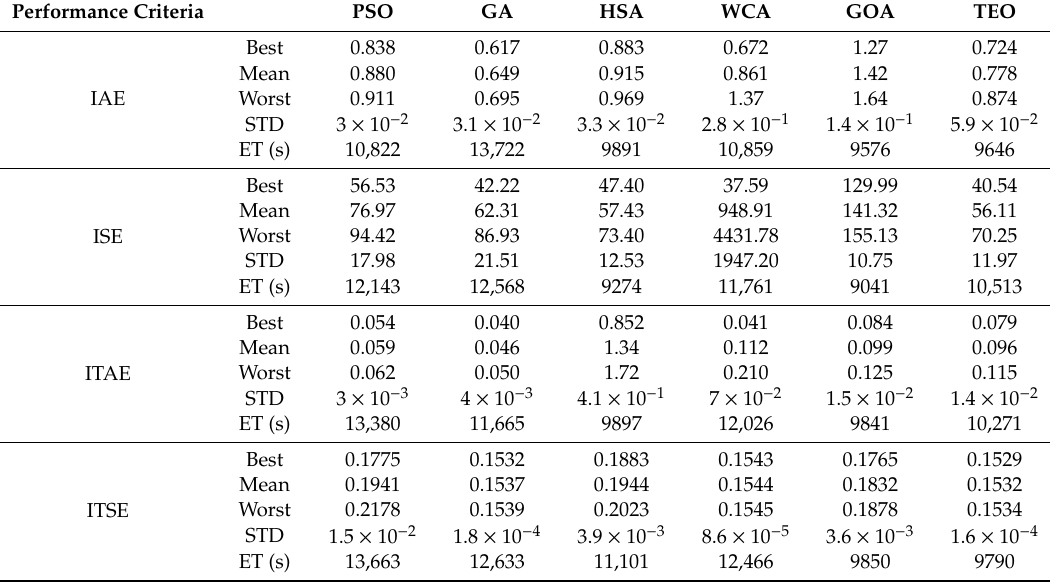
Table 1. Optimization results of the problem